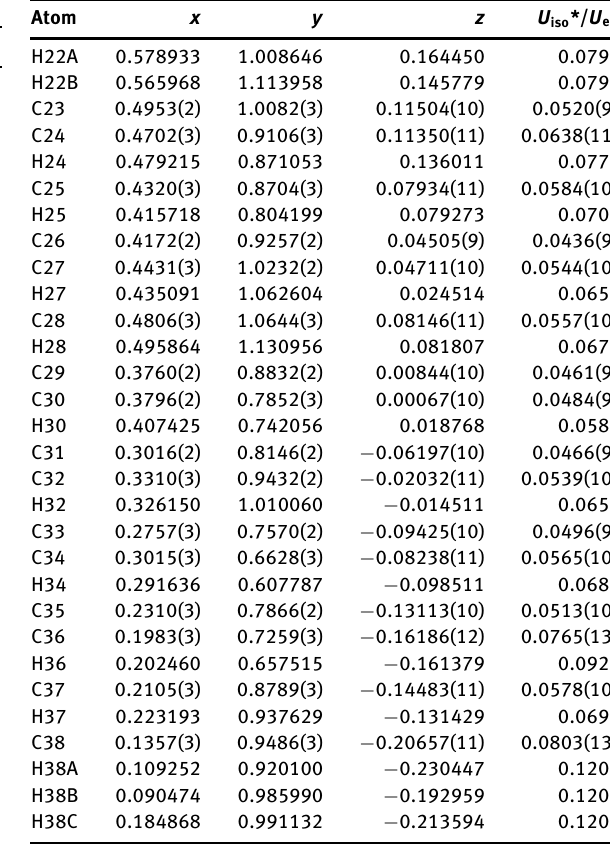
Table 2: Fractional atomic coordinates and isotropic or equivalent isotropic displacement parameters (Å 2